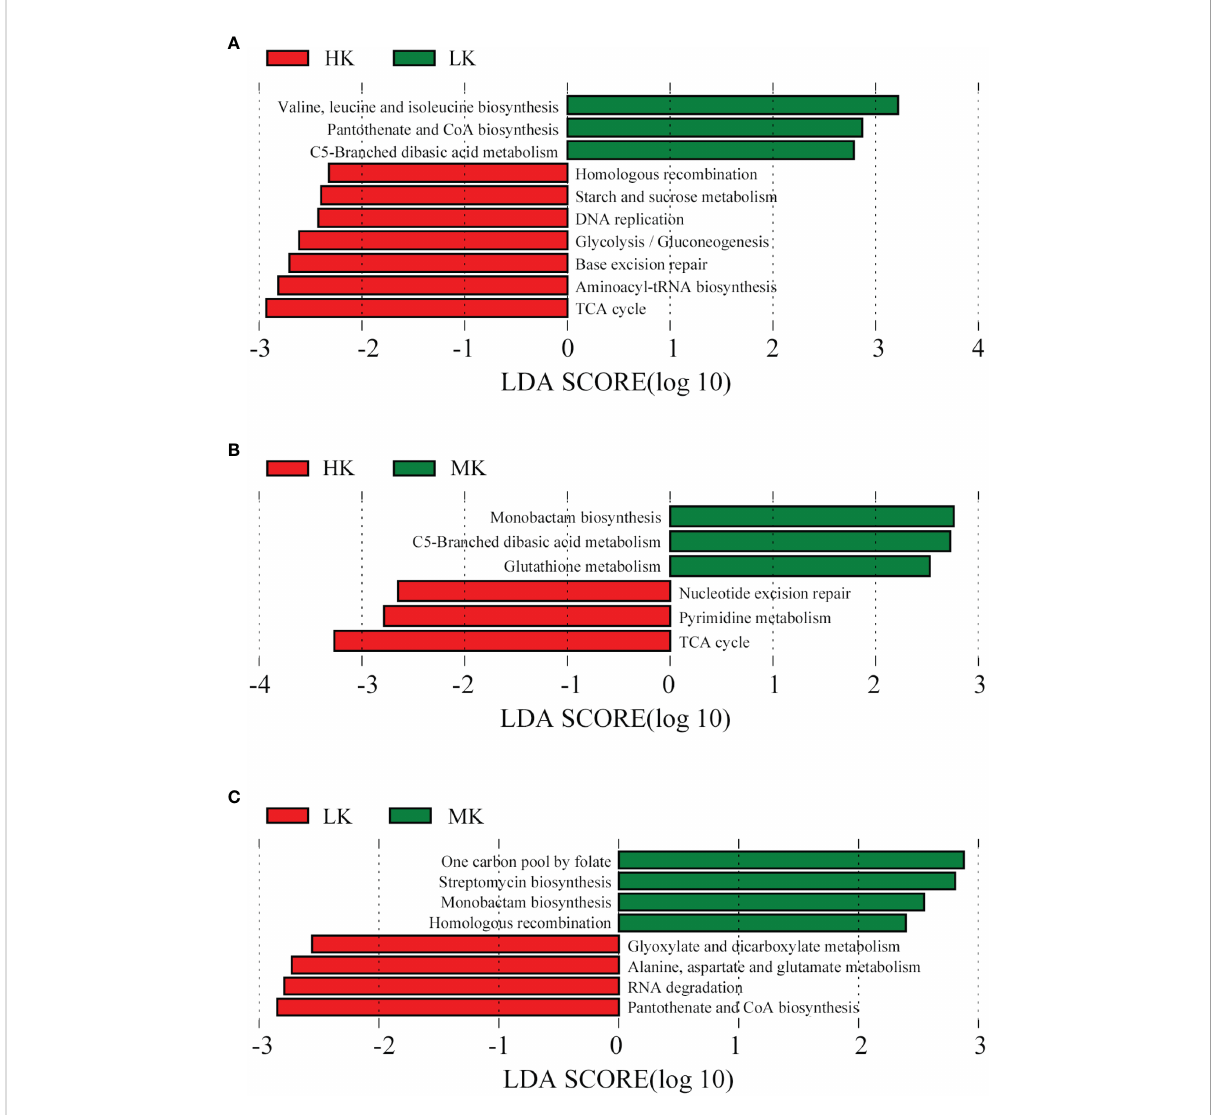
FIGURE 7 Histogram of the LDA effect value of differentially enriched KEGG pathways at level 3. Lineages with LDA values higher than 2.5 are displayed. (A) HK vs . LK; (B) HK vs . MK; (C) . MK vs .